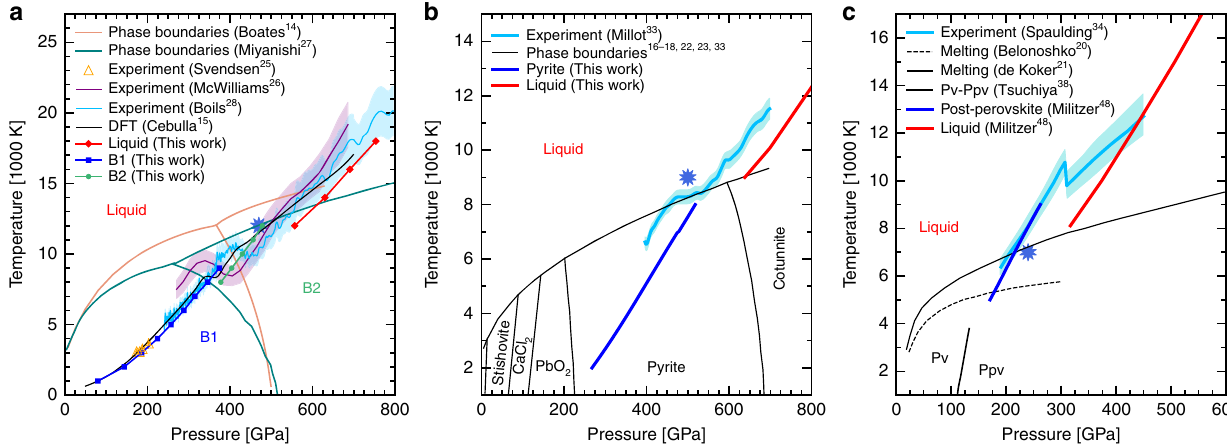
Fig. 1 Hugoniot curves and phase diagram of silicates. Phase diagram of a MgO 14,27 , b SiO 2 16 – 18,22,23,33 , and c MgSiO 3 20,21,38 are plotted. We added our predictions for the Hugoniot curves in the different phases as well as other fi rst-principles predictions 15,48 and experimental shock results 25,26,33,34 . The shaded areas represent the experimental uncertainty. The blue stars indicate the P – T conditions we chose for the liquid/solid